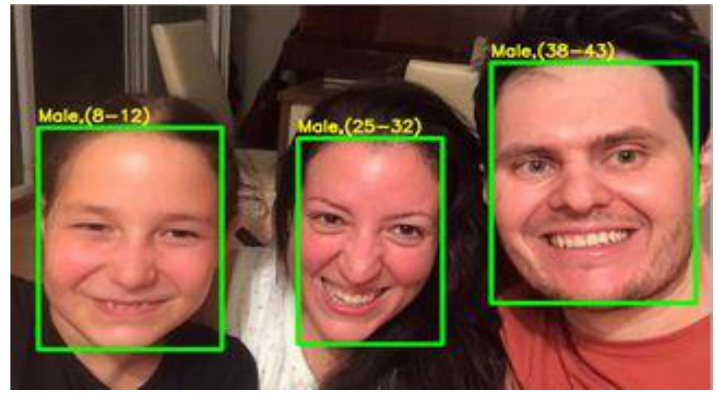
Fig. 12. Age and gender classification of a girl, a young woman and a middle aged